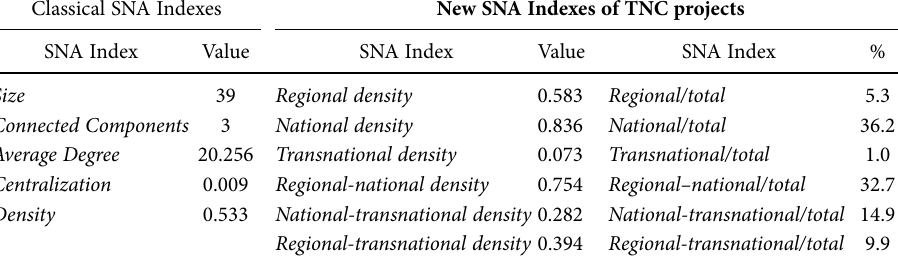
Table 5. Indexes of the transnational cooperation network of Veneto LAGs, LEADER II. Classical SNA